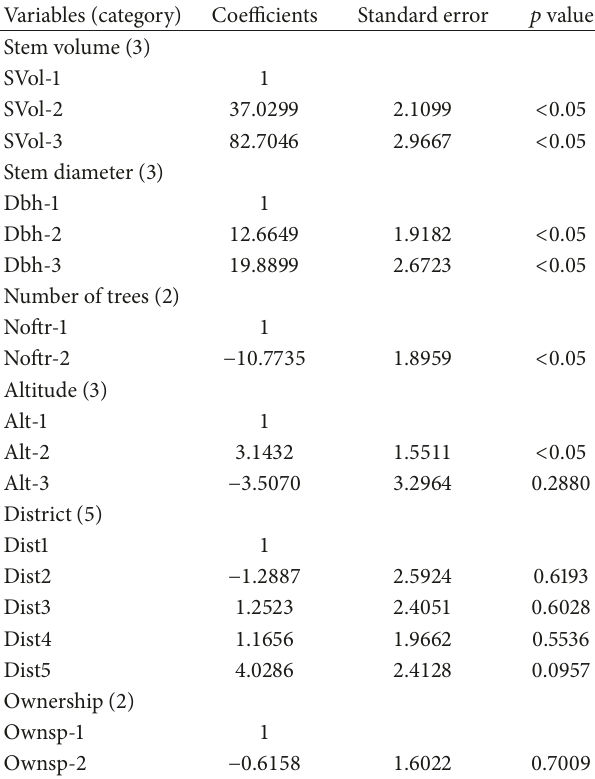
Table 3: Detailed result of variables after multiple regression